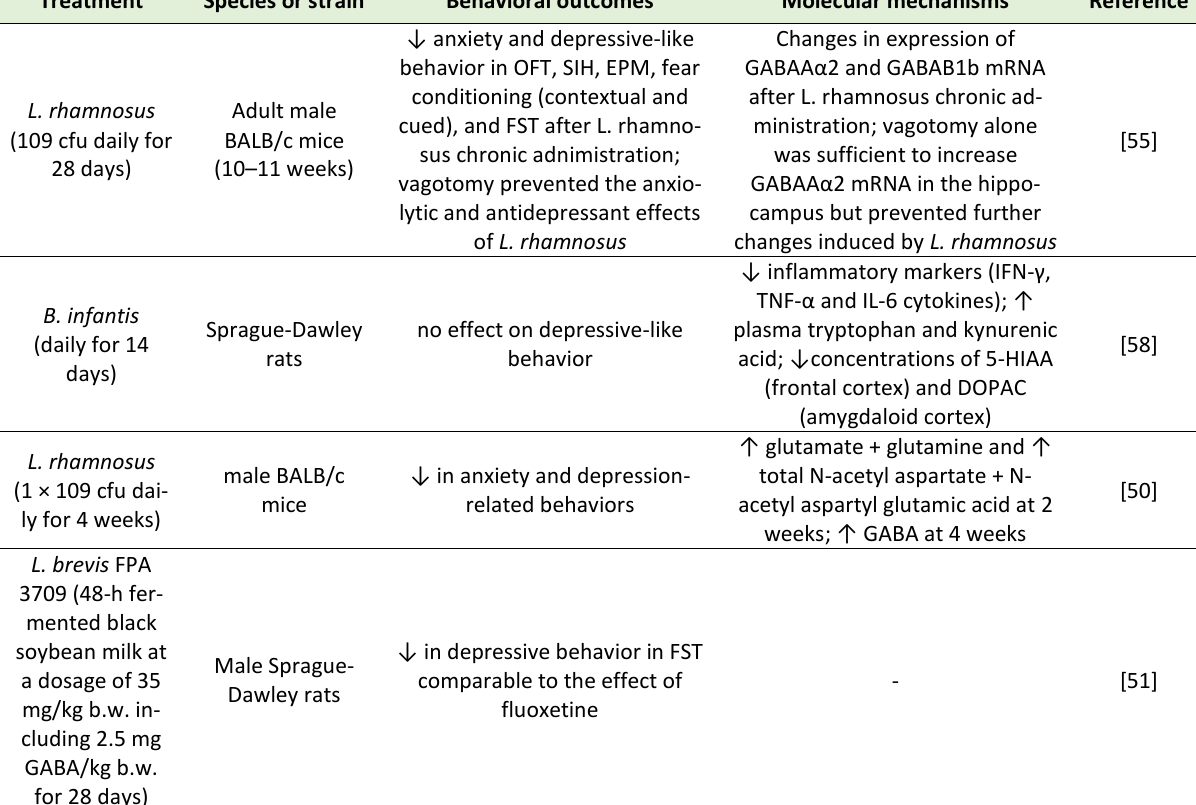
TABLE 2. Studies investigating the effects of treatment with microbial cultures on neurotransmission and behavior. Treatment Molecular mechanisms